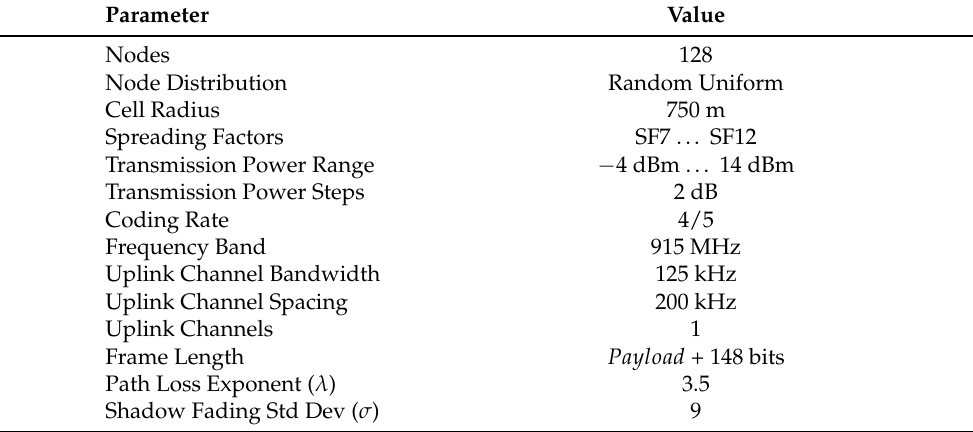
Table 1. Common simulation parameters.